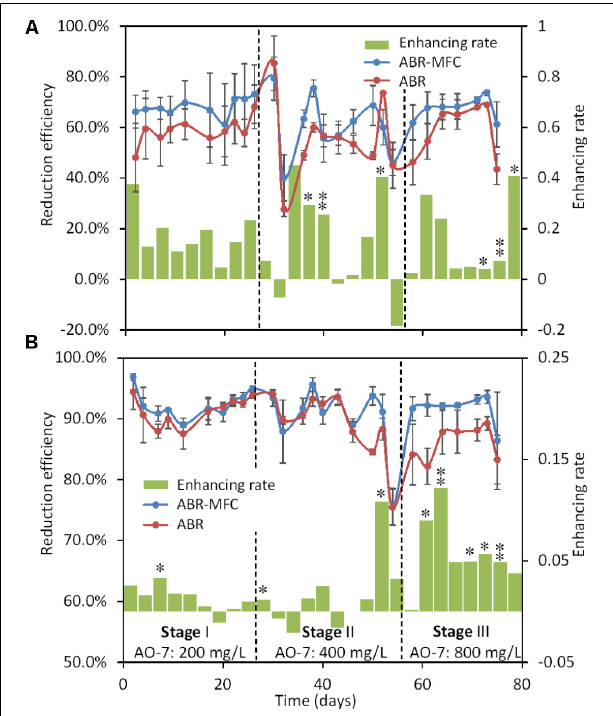
FIGURE 2 | The enhancement of MFC-ABR on AO-7 reduction in chamber-1 (A) and the whole reactor (B) . ( ∗ p < 0.05; ∗∗ p < 0.01).